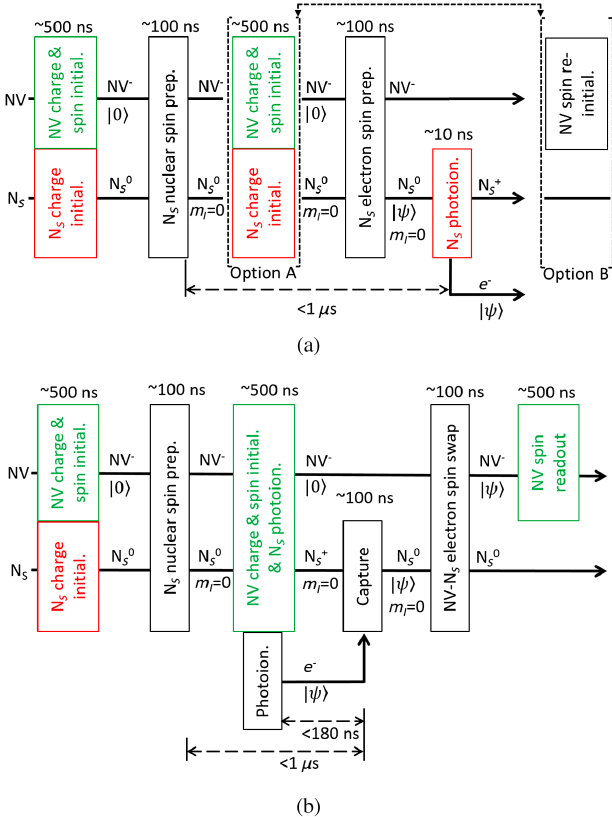
FIG. 2. Techniques to (a) photoionize an electron with spin pair and to (b) subsequently capture state j ψ i from a NV- 14 N S pair. Each box and optically detect its spin at another NV- 14 N S corresponds to an optical or microwave pulse described in the text and has its indicative length denoted above. For optical pulses, the box color represents the wavelength of the pulse (red, 1.7 – 1.946 eV; green, typically 2.32 eV). The evolution of the charge and spin states of each defect and the transport electron are represented by solid arrows and are as annotated. The respective 1 - μ s and 180-ns time frames for 14 N nuclear spin and transport S electron spin relaxation are indicated by dashed